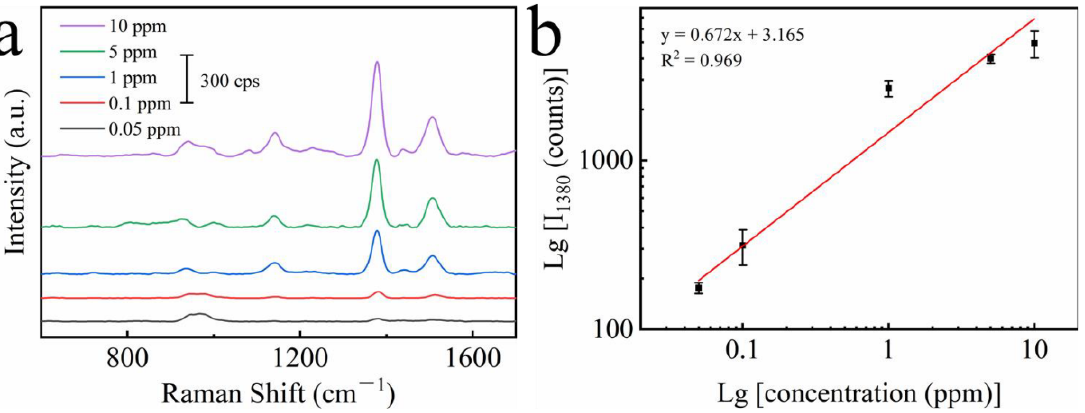
Figure 6. ( a ) Raman spectra of thiram with various concentrations on Au–Ag alloy HNCs substrate. ( b ) Relationship between the intensity of the SERS peak at 1380 cm − 1 and thiram concentration; the error bar is based on four parallel SERS spectra.